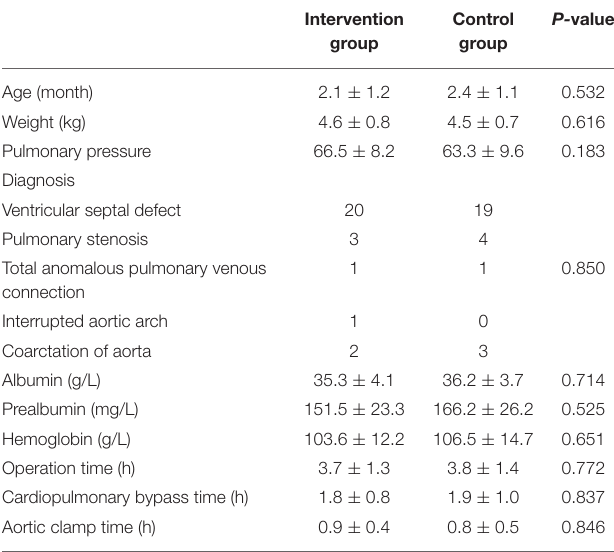
TABLE 2 | Comparison of general information of the two groups.